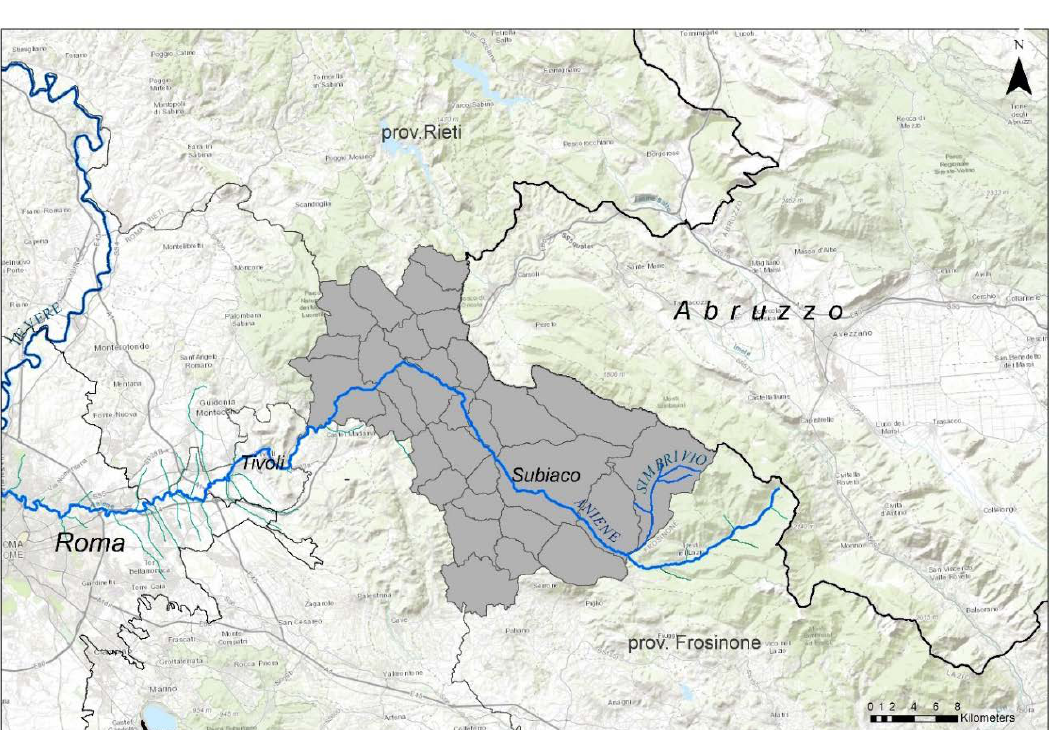
Figure 1: Territorial delimitation of the Aniene Valley on the basis of the municipalities (highlighted in grey) of the 10 th Aniene Mountain Community. Scale: 1:250.000. This map was created using ArcGIS® software by Esri Cartography: Francesca IMPEI, June